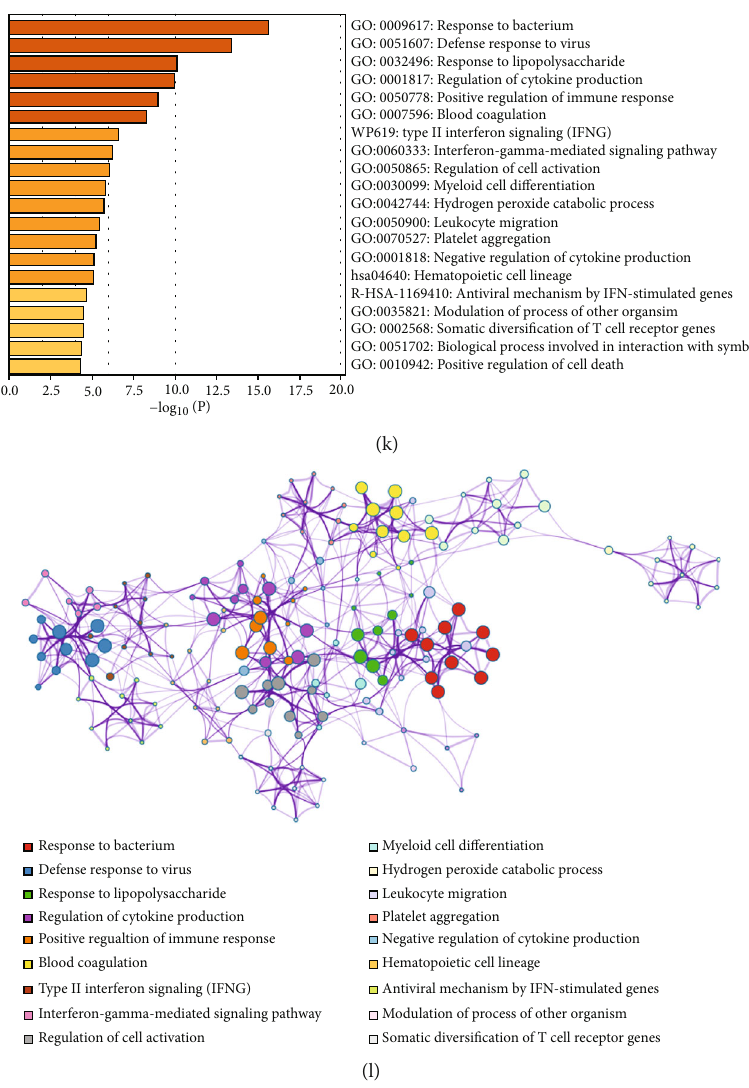
Figure 3: Data set E-MTAB-4257 di ff erence analysis and enrichment analysis. (a – d) Gene Set Enrichment Analysis. (e – h) Weighted gene coexpression network analysis. (i) Di ff erential gene volcano map. (j – l) Gene Ontology and Kyoto Encyclopedia of Genes and Genomes pathway enrichment